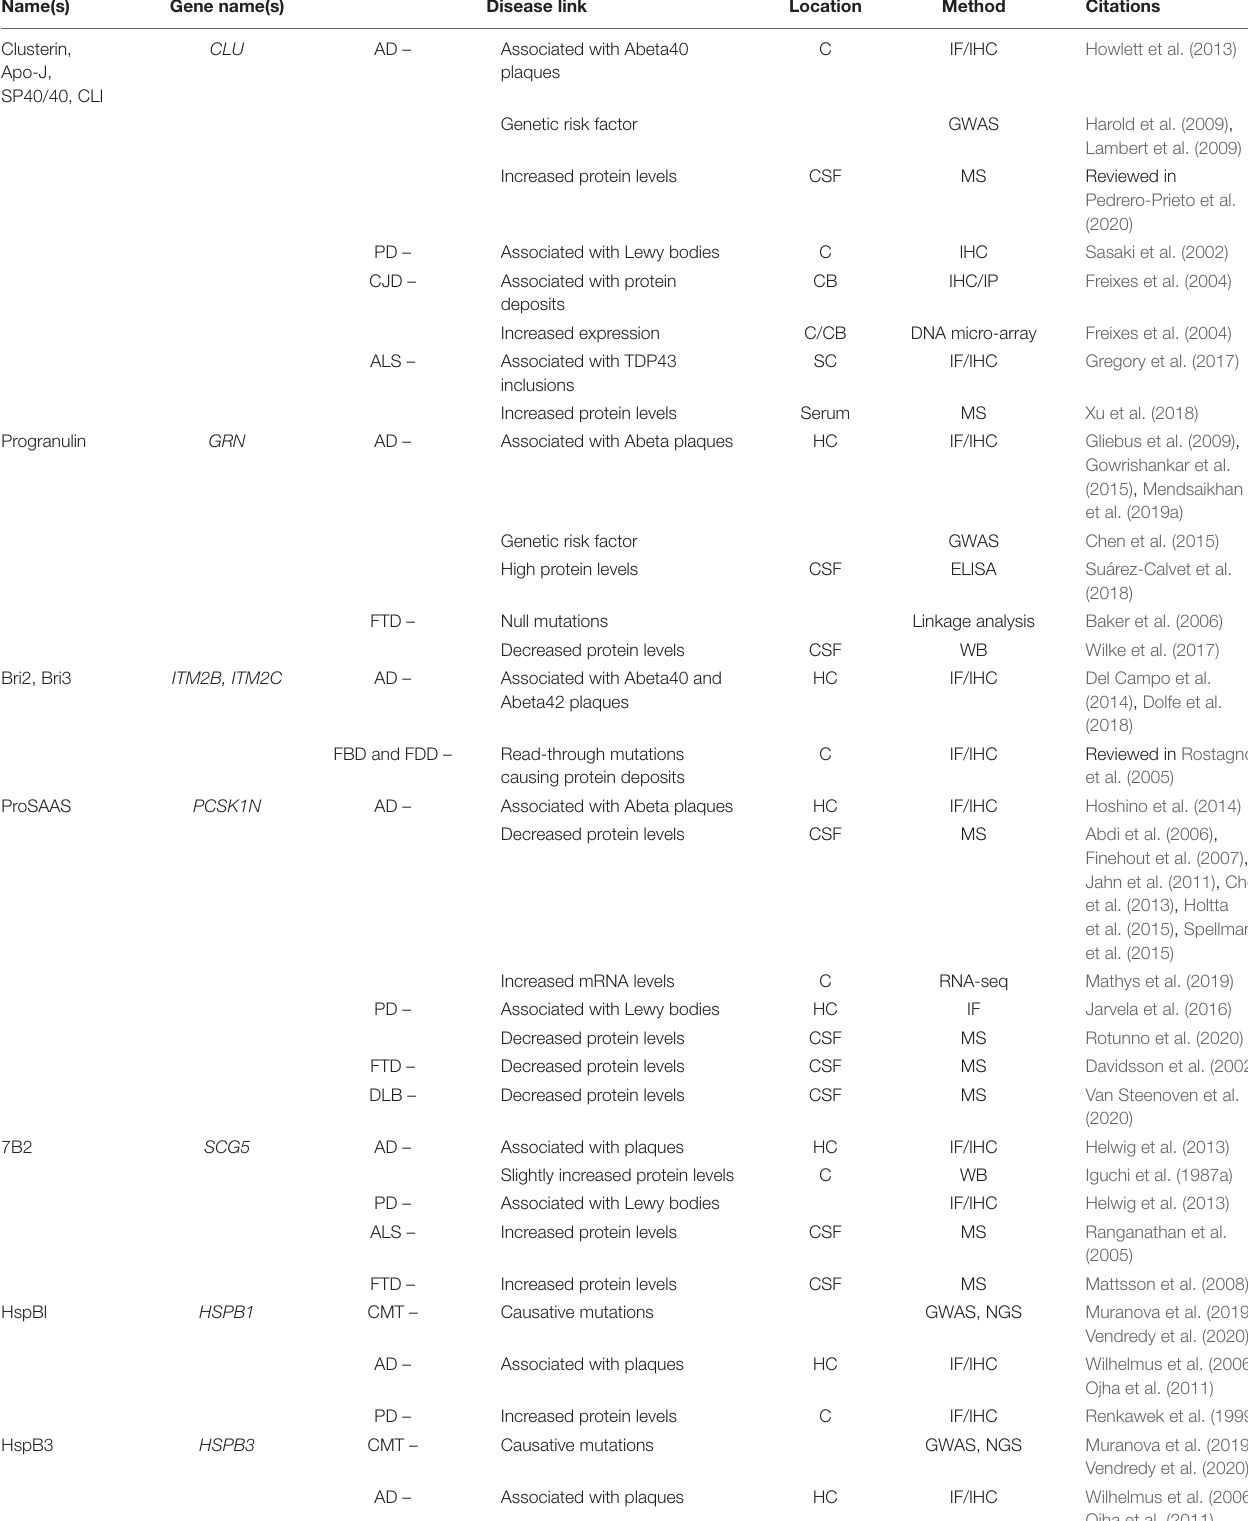
TABLE 1 | Extracellular chaperones implicated in neurodegenerative diseases - Human